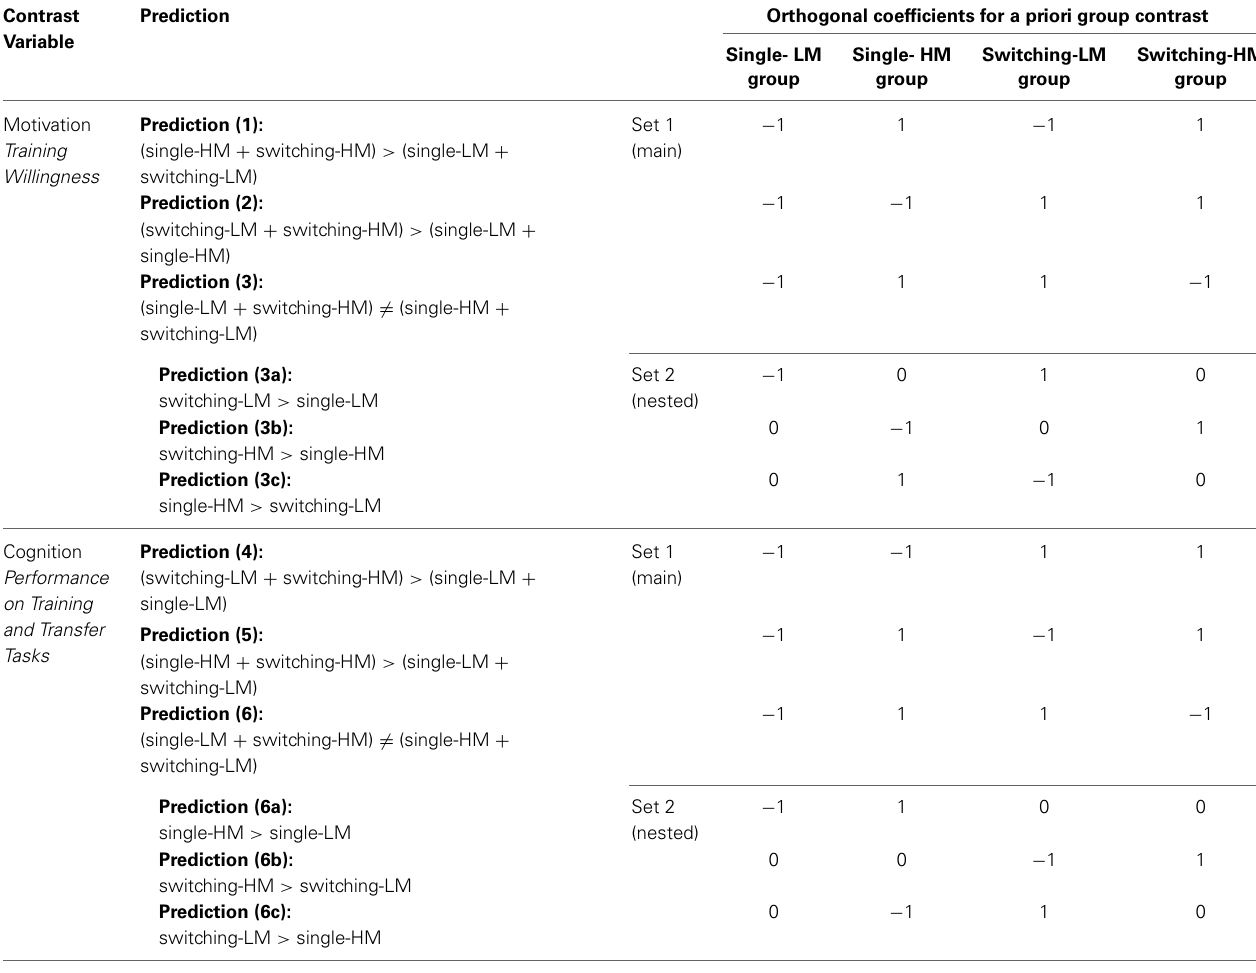
Table 2 | Orthogonal coefficients for a priori group contrasts. Contrast Variable